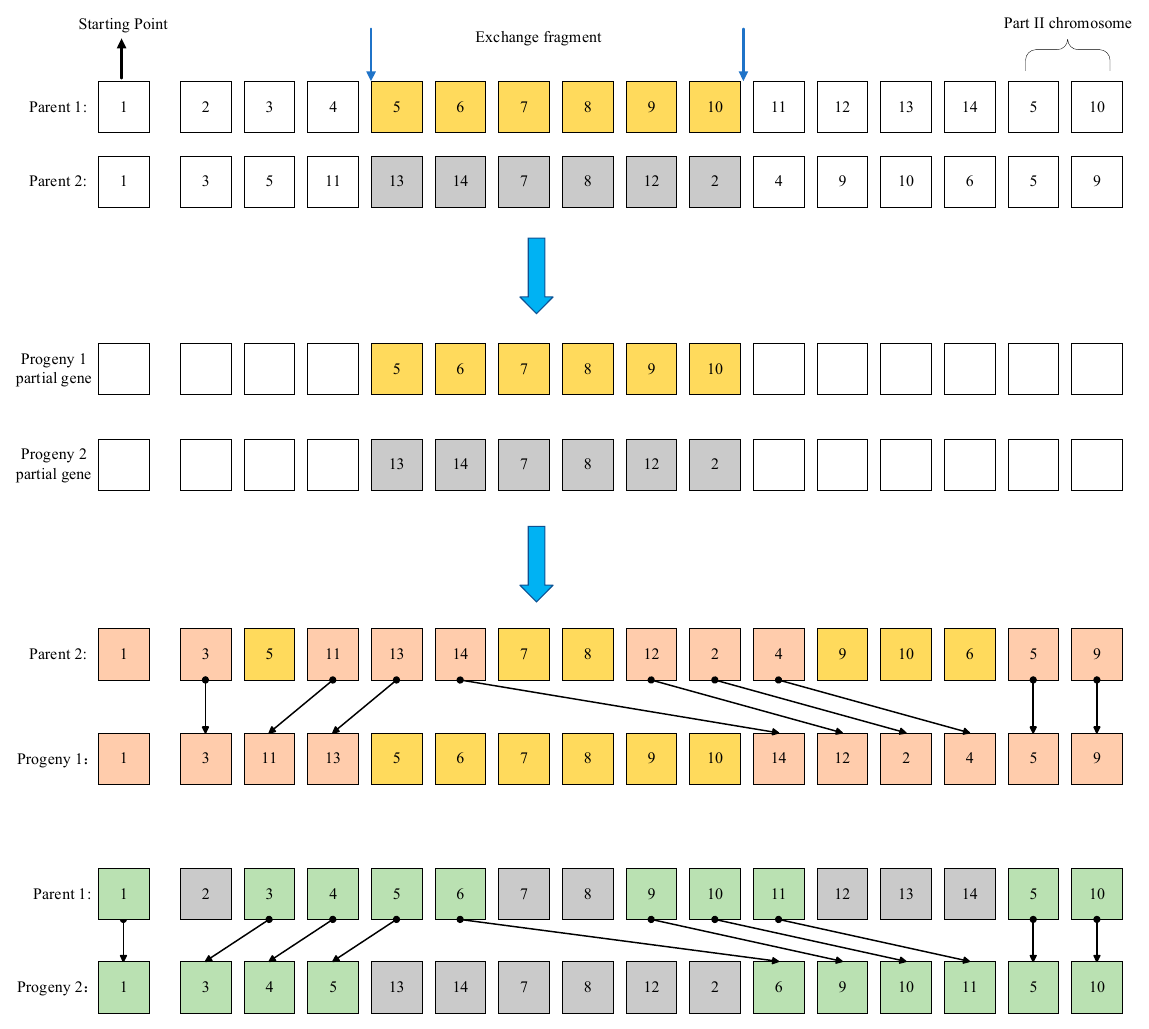
Figure 4. Order cross operation ( m = 14).